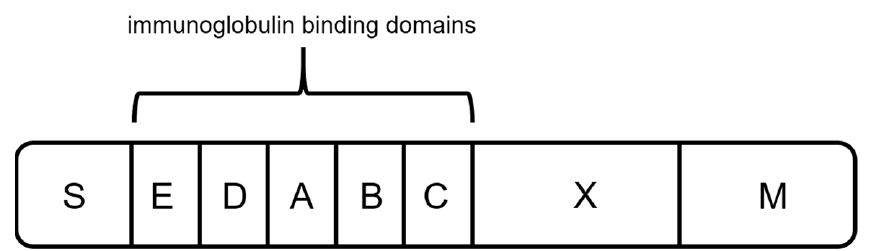
Figure 4. Schematic sketch of protein A, composed of a signal sequence (S) domain, five homologous immunoglobulin binding domains (E, D, A, B, and C), and a cell-wall anchoring domain (X, M) [56]. Each of the immunoglobulin-binding domains can bind to one Fc domain of an antibody or to the Fab region of V H 3 human antibodies [55,57,62,63]. Staphylococcal protein A (SPA) binds strongly to Fc domains of IgG1, IgG2, and IgG4 and has a weaker